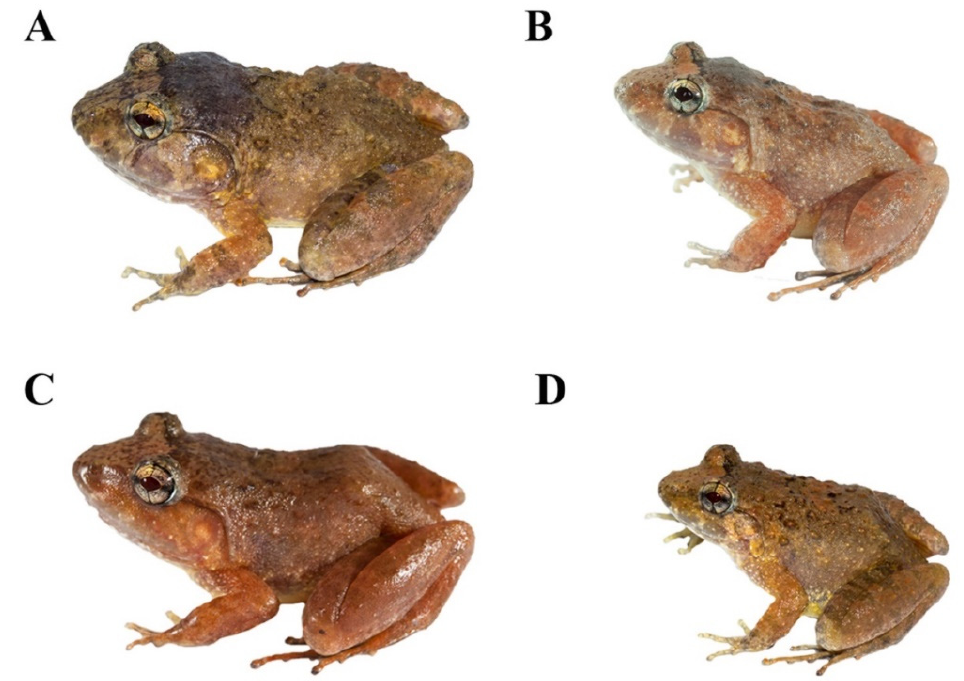
Figure 7. Paratypes of Limnonectes pseudodoriae sp. nov . ( A ) adult male (ZMKU AM 01568), ( B ) adult male (ZMKU AM 01575) from Ko Pha-ngan Island. ( C ) Adult male (ZMKU AM 01555) from Ko Lanta Yai Island and ( D ) adult female (ZMKU AM 01573) from Ko Pha-ngan Island.